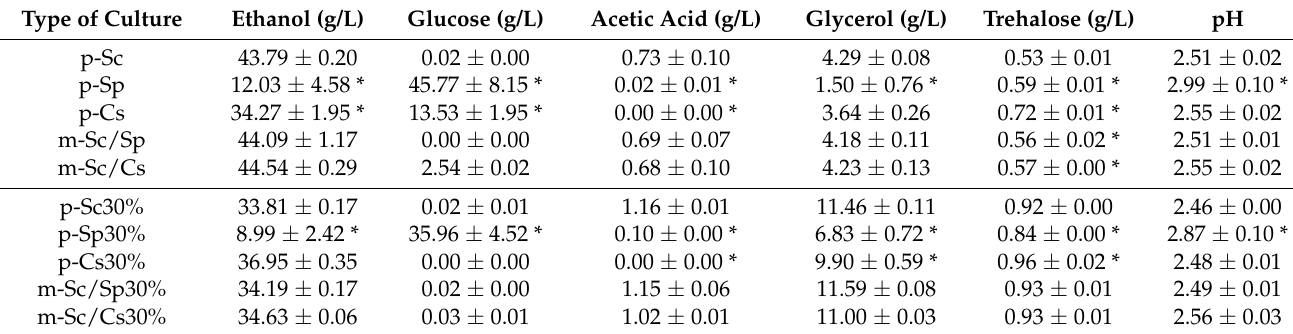
Table 2. Fermentative parameters produced by pure and mixed cultures with S. cerevisiae , S. pombe and C. stellata in YNB + glucose medium (control) and YNB + glucose + 30% sorbitol (stressful medium). Data are means ± standard deviation (n = 3). Asterisks (*) denoted significant differences regarding the controls, p-Sc, and p-Sc30% (Tukey test; p < 0.05). Type of